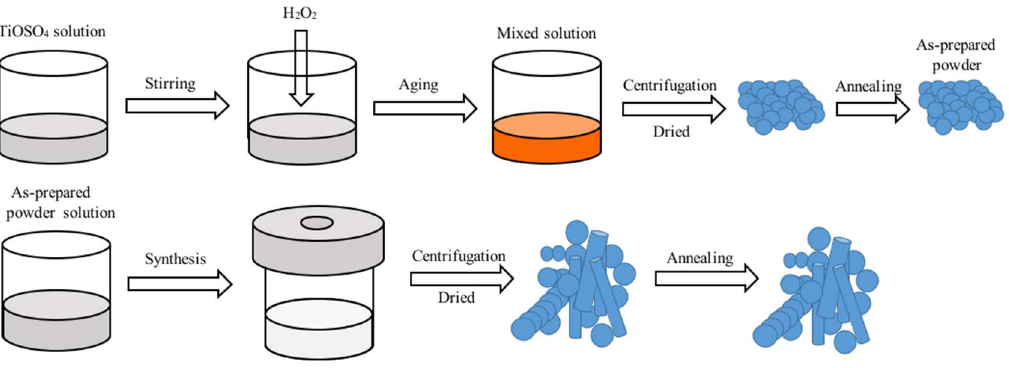
Scheme 1. Schematic illustration of the different steps for TiO 2 powder